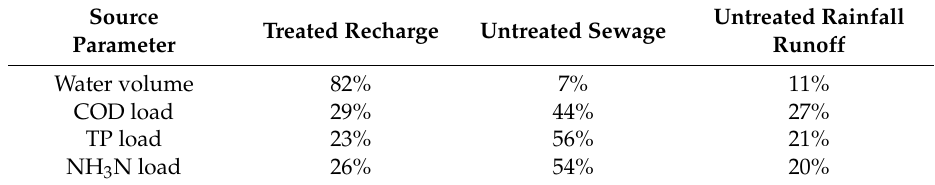
Table 2. Contribution of nutrient sources to water volumes and nutrient loads into the